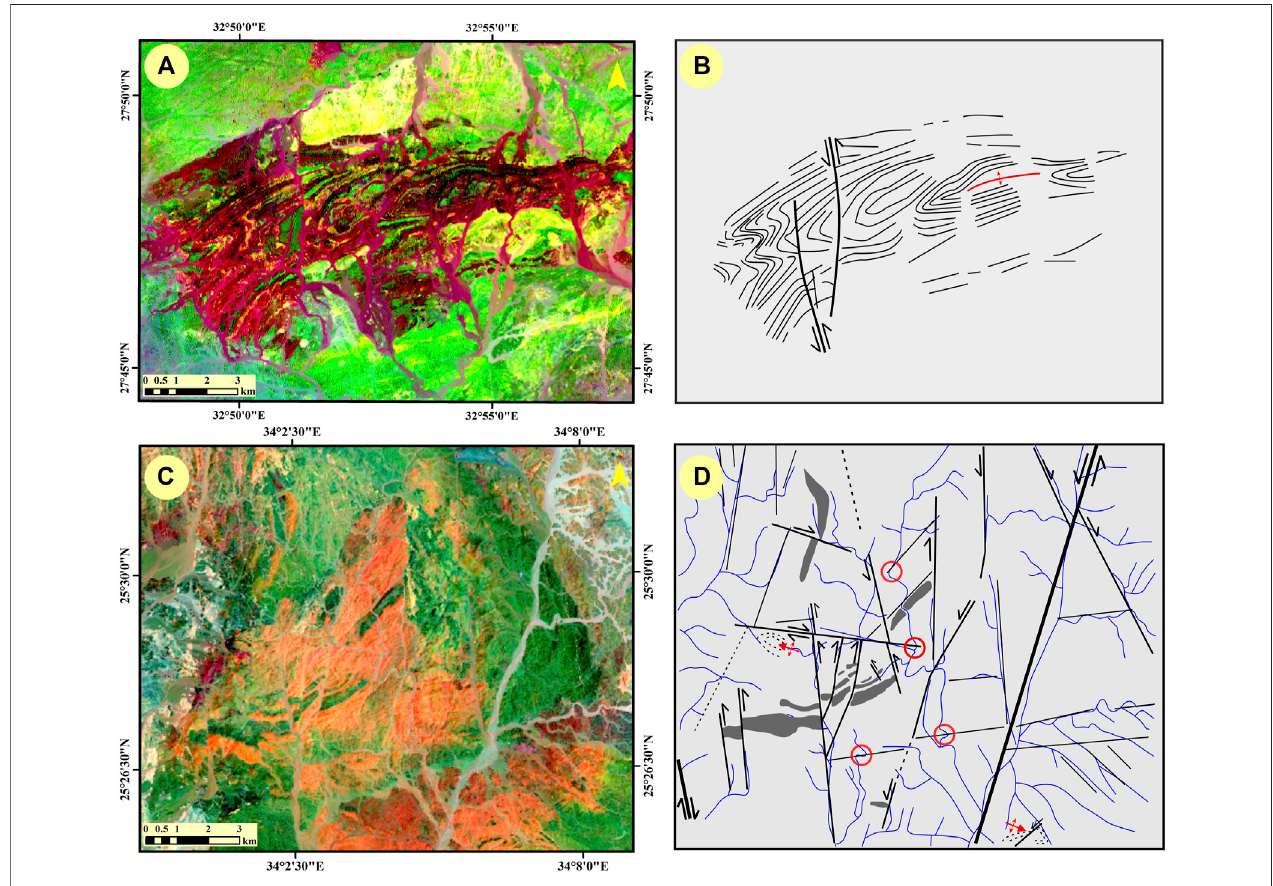
FIGURE 9 | (A,C,E,G) The band ratio BR RGB (6/7, 6/5, 4/2) of the processed Landsat-8 images and (B,D,F,H) their structural interpretation of El-Uref (NED), W. El-Arak (CED), W. El-Miyah (CED), and W. El-Allaqi (SED), respectively. Note that the red circles in (D) show the offset drainage by the strike-slip faults.